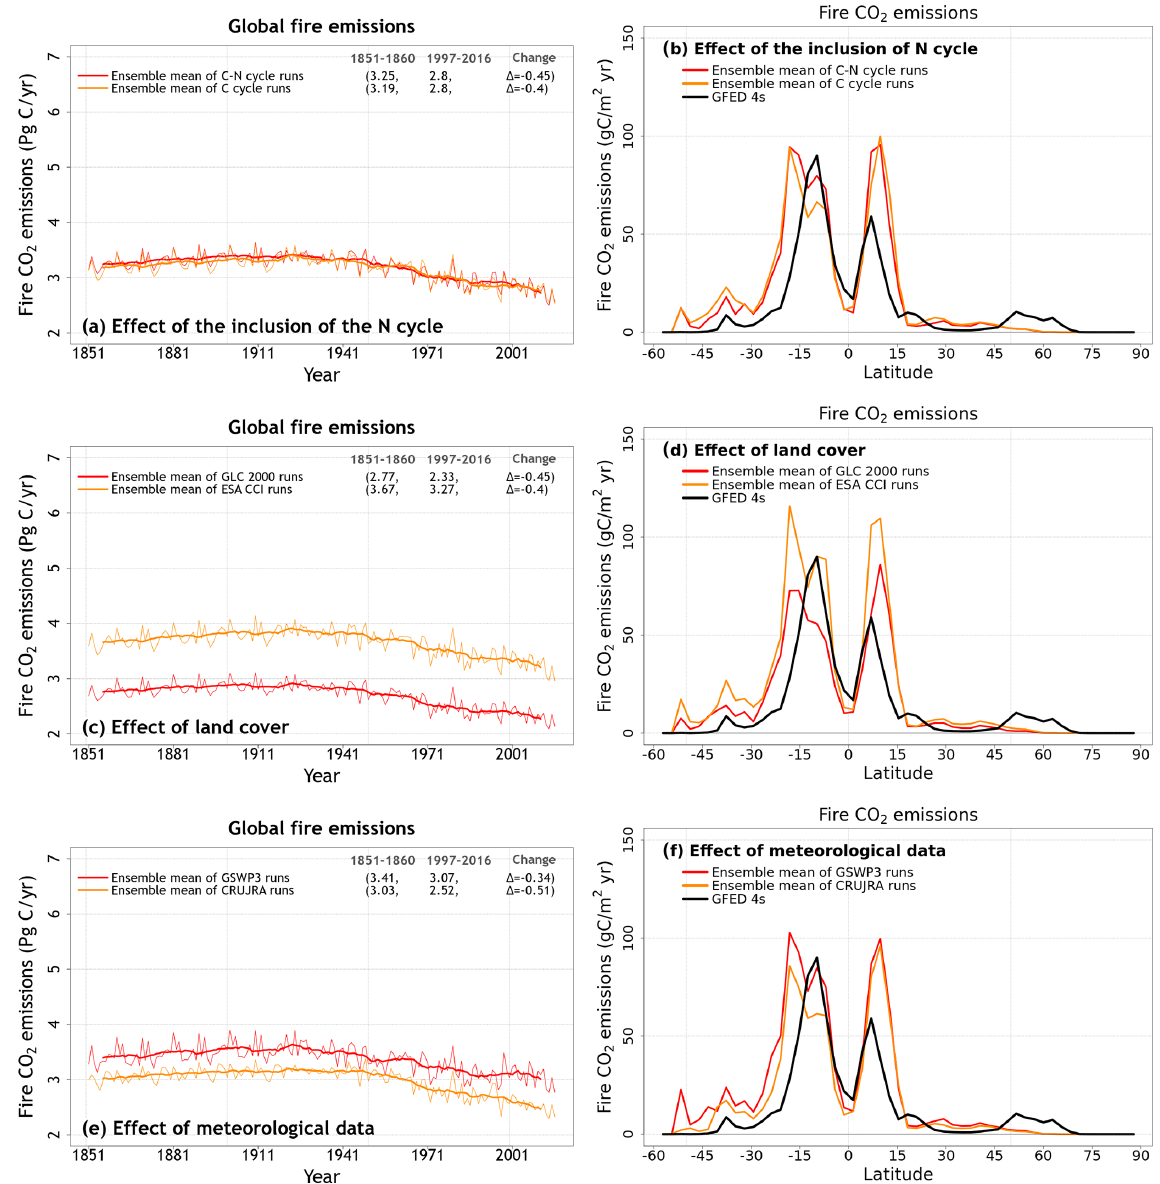
Figure A10. Time series of global fire CO 2 emissions (over all land area excluding Greenland and Antarctica) (a, c, e) and their zonally averaged values (b, d, f) averaged over the four ensemble members that are driven with and without an interactive N cycle (a, b) , that are driven with the GLC-2000- and ESA-CCI-based land cover (c, d) , and that are driven with GSWP3 and CRU-JRA meteorological data (e, f) . The thin lines for the time series show the individual years, and the thick lines show their 11-year moving average in (a) , (c) , and (e) . Model values averaged over the pre-industrial (1851–1860) and present-day (1997–2016) time periods, and their difference, are also shown for (a) , (c) , and (e)